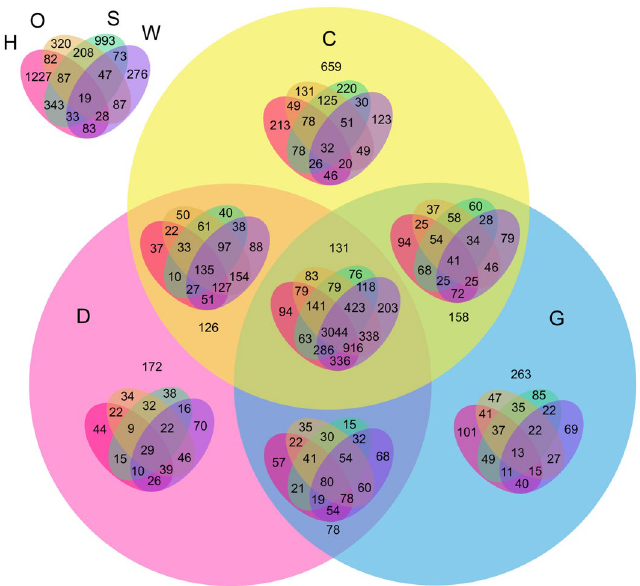
Figure 5. 7-set Venn diagram of gene ids present in B subunit across all stress conditions. H: Heat, O: Osmotic, S: Salt, W: Wounding, D: Drought, C: Cold, G: Genotoxic. The 7-set Venn diagram illustrates the count of genes in all 127 possible